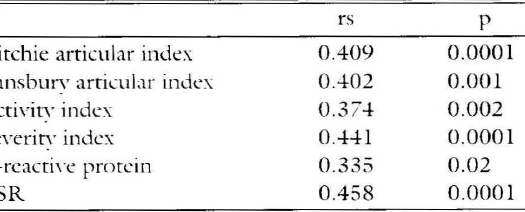
Table 3. Spearman rank codlicients (rs) of correlation between serum ncopterin concentrations and the main clinical and laboraton' parameters in patients with rheumatoid arthritis